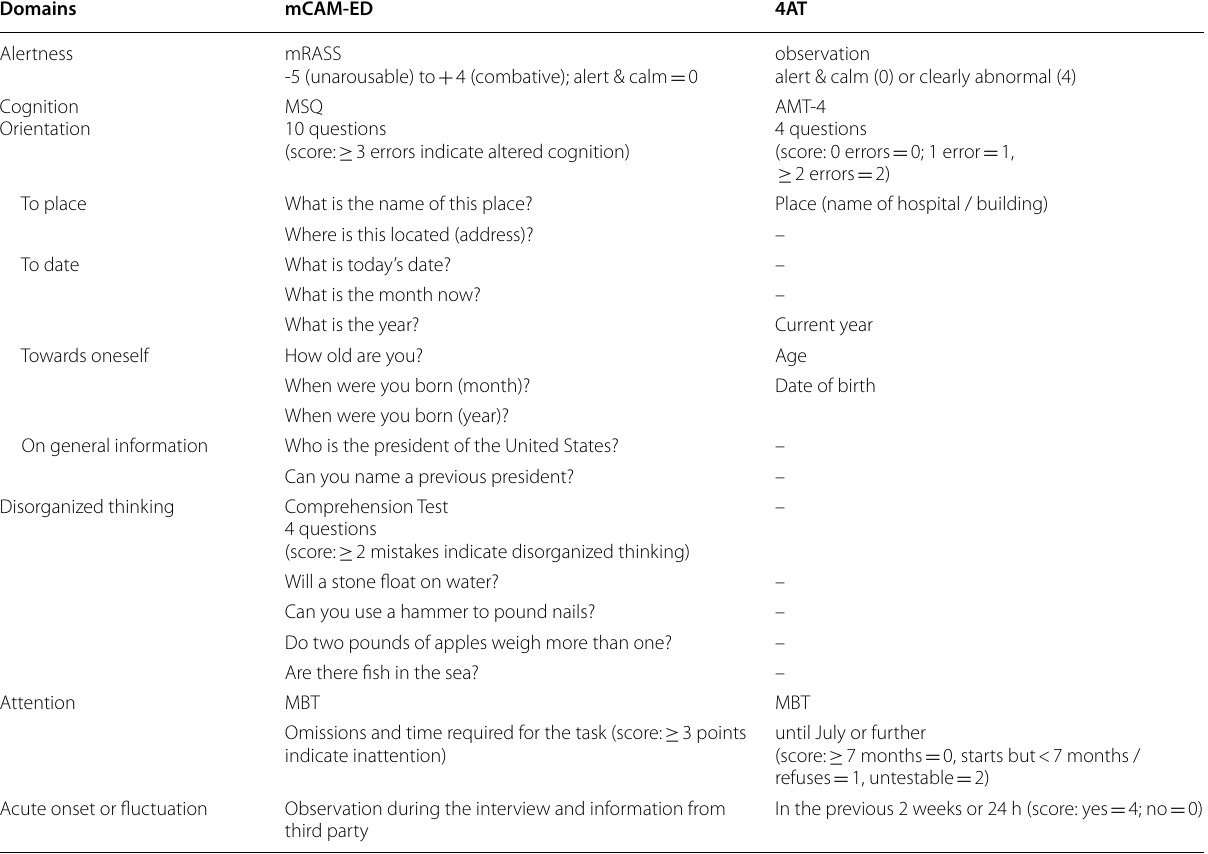
Table 1 Variables of the mCAM-ED and the 4AT, listed according to the